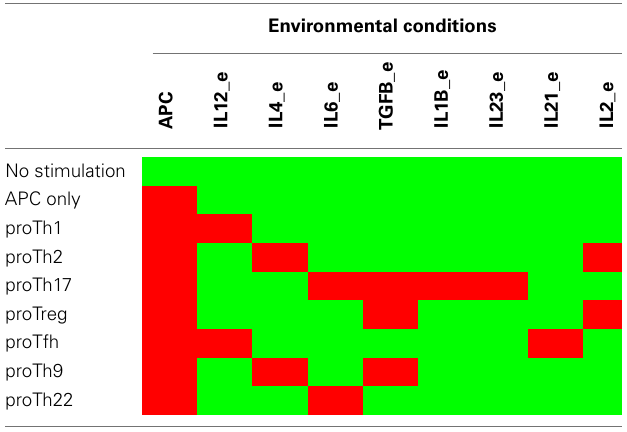
Table 3 | Prototypic environmental conditions